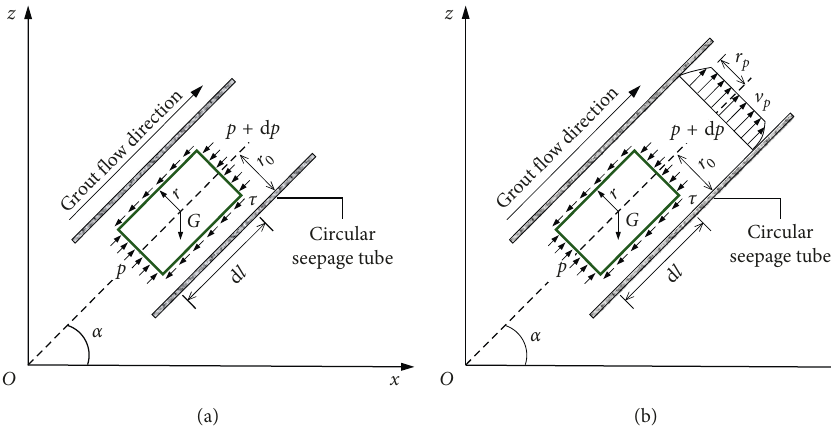
Figure 2: Geometry of the physical model. (a) Power-law grout and (b) Bingham